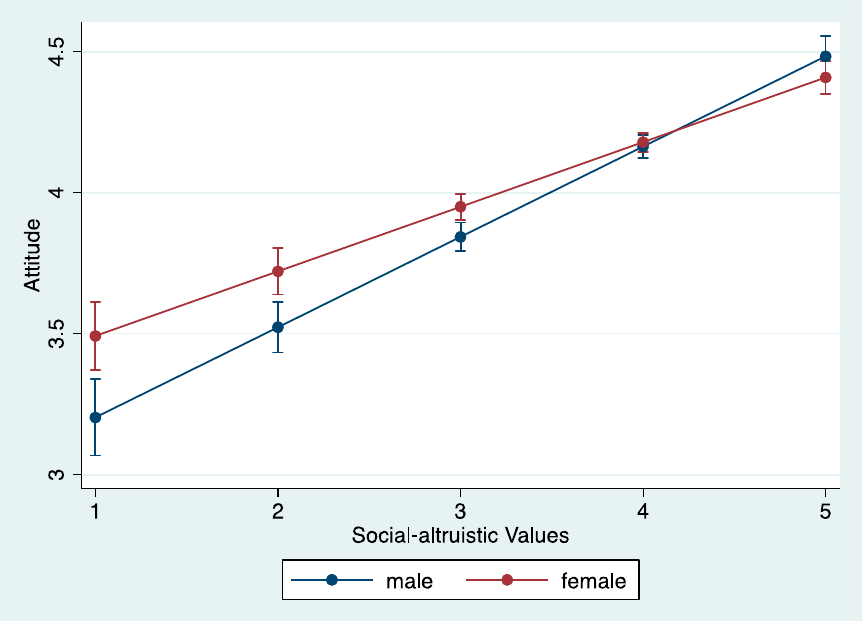
Figure 7. Interaction plot of gender and altruistic values on attitudes.